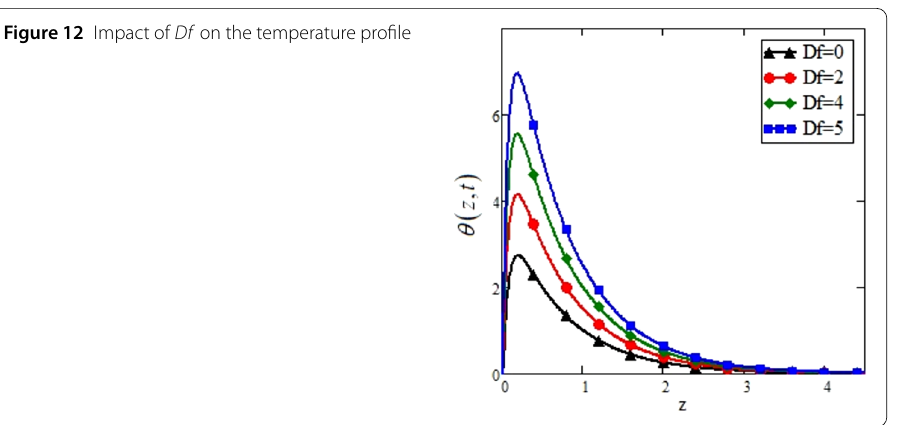
Figure 12 Impact of Df on the temperature profile